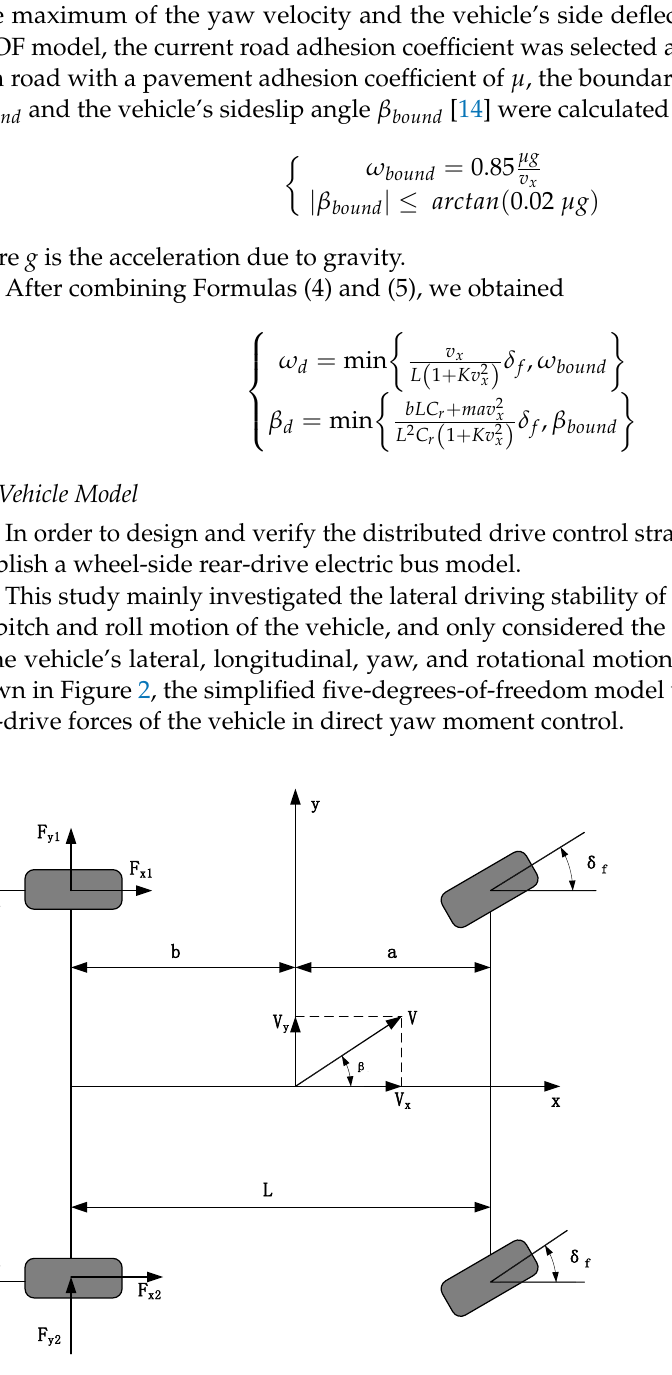
Figure 2. Five-degrees-of-freedom kinematics scheme. Longitudinal motion equation: